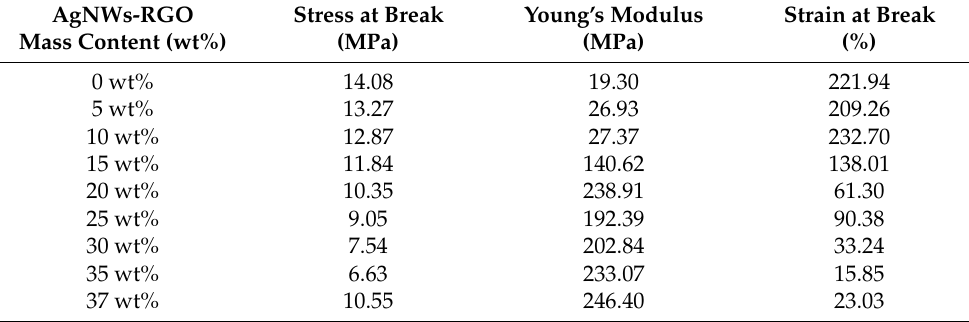
Figure 10. Stress–strain curves ( a ) and tensile strength ( b ) of the composite films with different AgNWs-RGO contents. Table 1. Mechanical properties of the composite